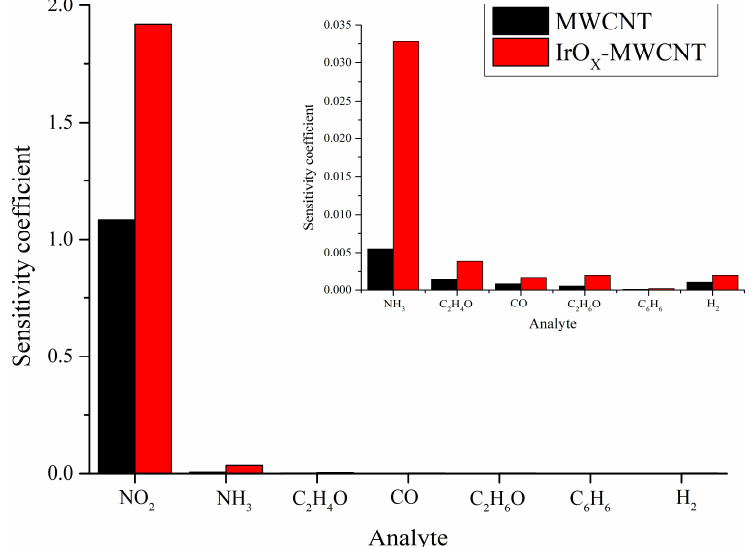
Figure 6. Sensitivity coefficient expressed as response/concentration for the different species tested (the inset is an enlargement showing the coefficients for those gaseous species with lower sensitivity coefficients). The sensitivity coefficients were obtained employing the highest response registered at specific concentrations, which were 1 ppm for NO 2 ; 20 ppm for C 2 H 6 O and C 6 H 6 ; 100 ppm for CO, C 2 H 4 O and NH 3 ; and 1000 ppm for H 2 .